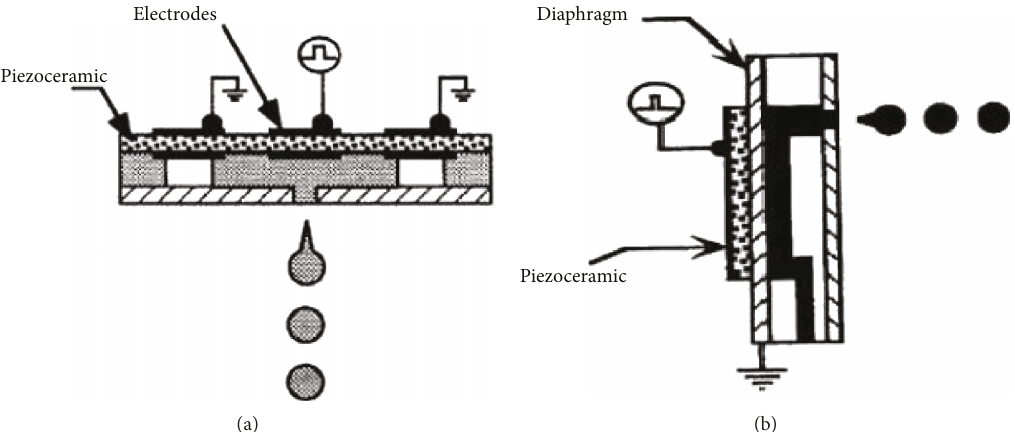
Figure 2: Design of a (a) shear-mode and (b) bend-mode piezoelectric inkjet print head [36].